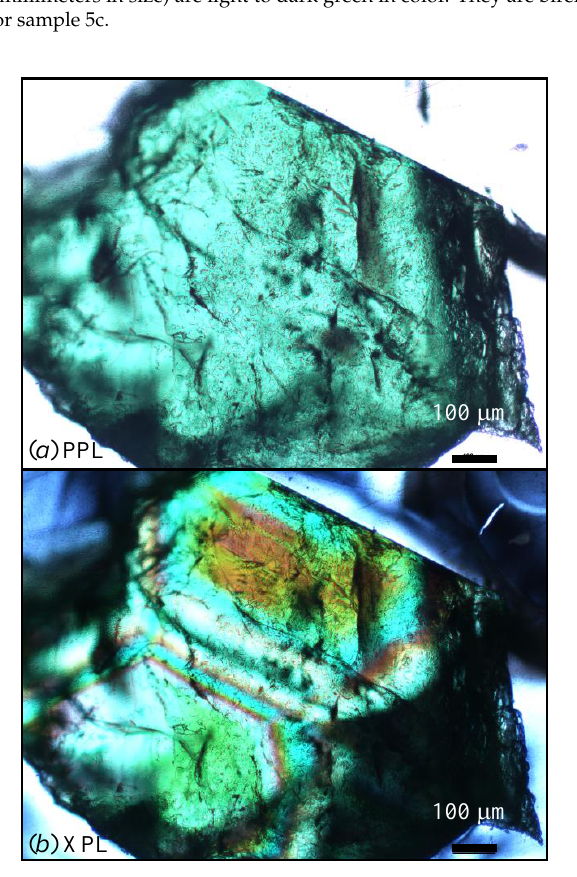
Figure 2. ( a ) Plane-polarized (PPL) and ( b ) cross-polarized (XPL) light images for uvarovite (Uv) sample 1 from Russia. The images are from a double-sided polished thin section of 50 m thickness. Except for sample 5c, all the other Uv samples are birefringent in XPL. Table 1. Localities of the uvarovite samples † used in this study.